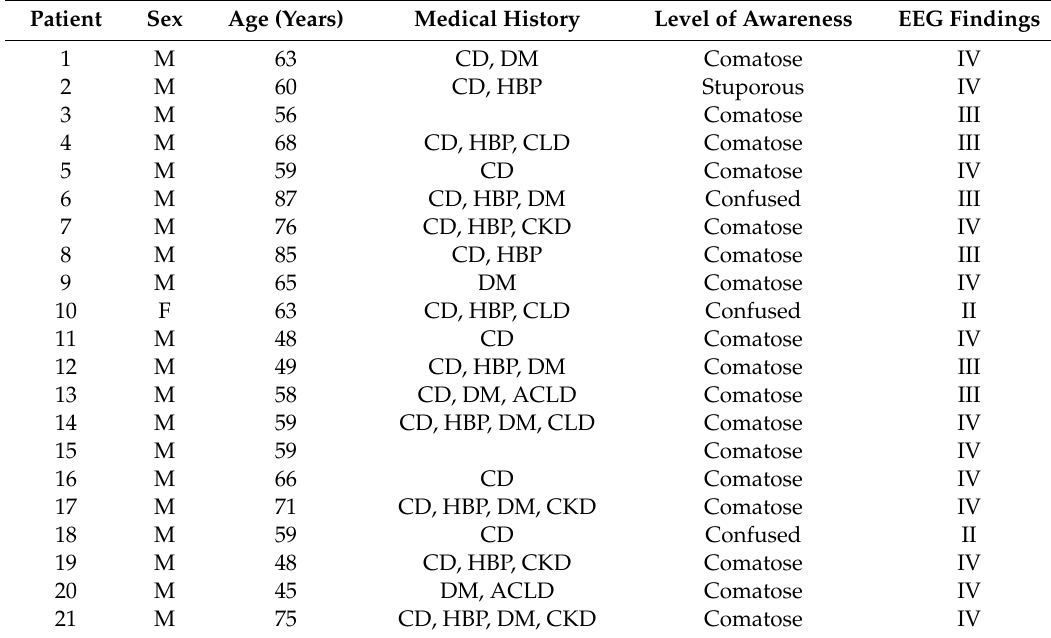
Table A3. Patients with encephalopathy after cardiorespiratory arrest